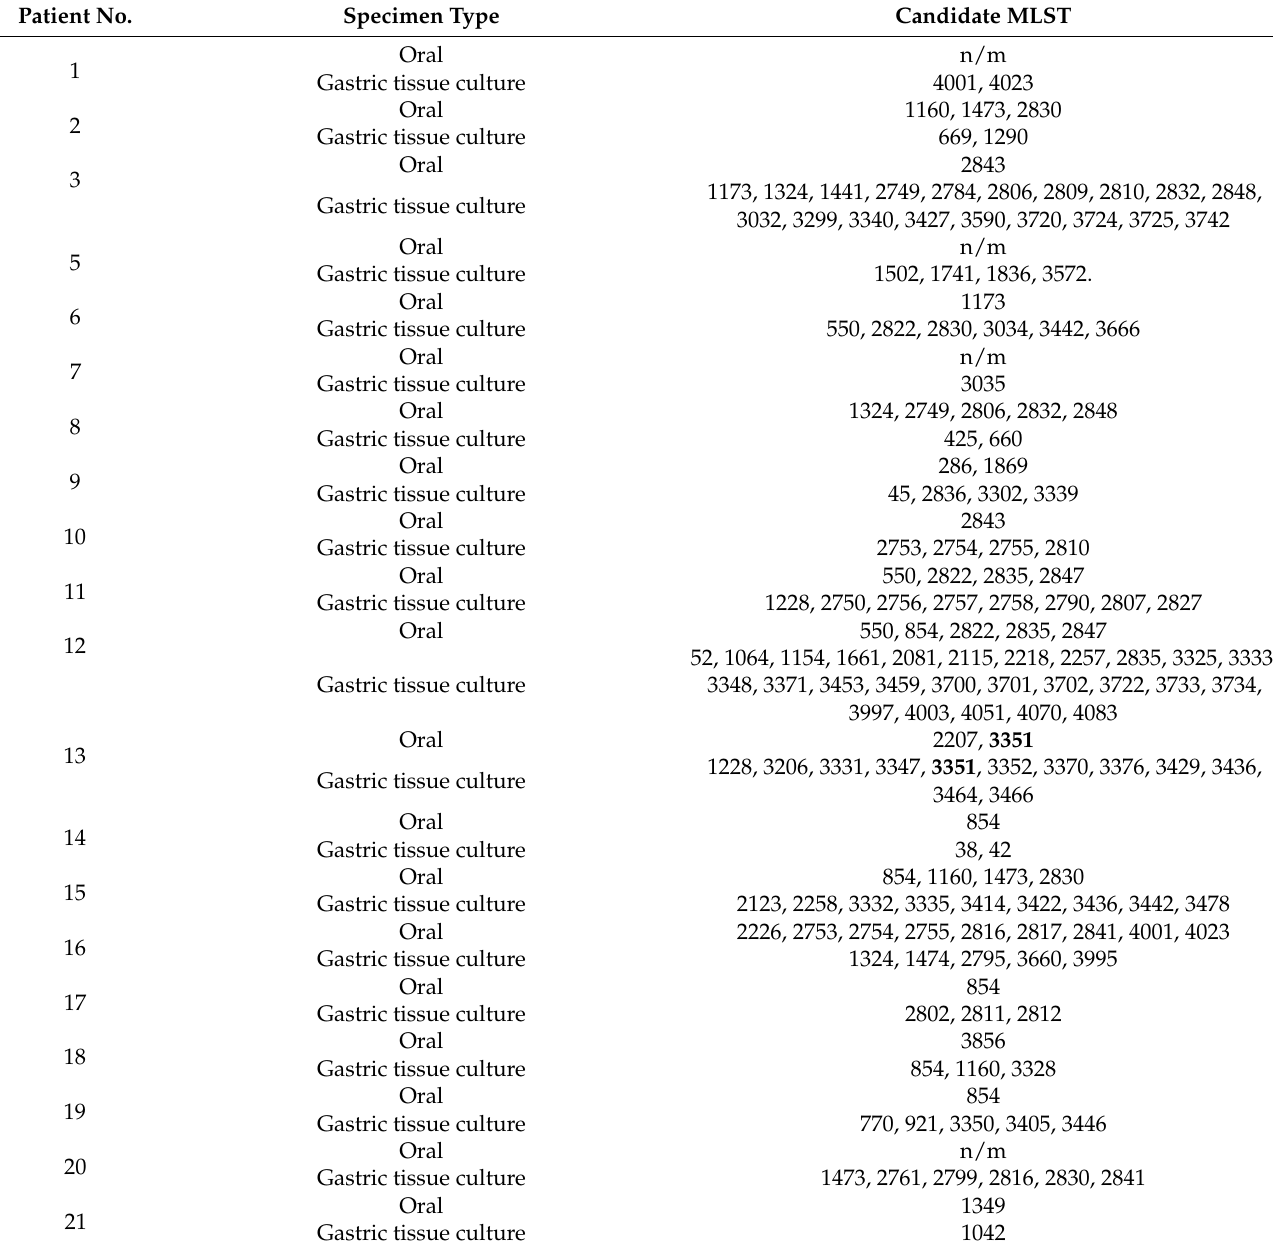
Table 4. MLST profiles of oral and gastric H. pylori